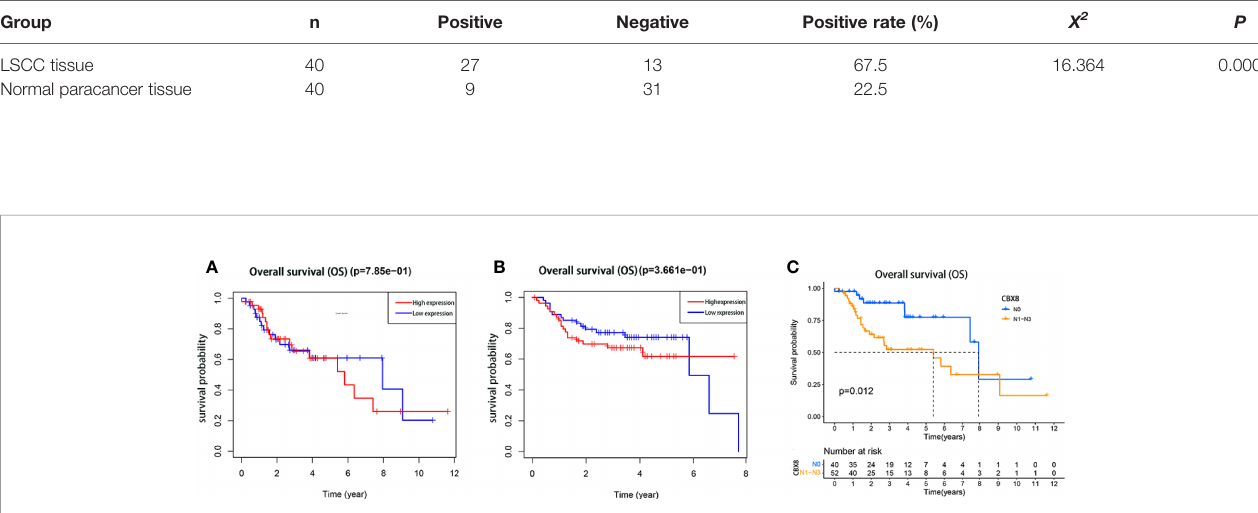
TABLE 1 | Expression of CBX8 protein in